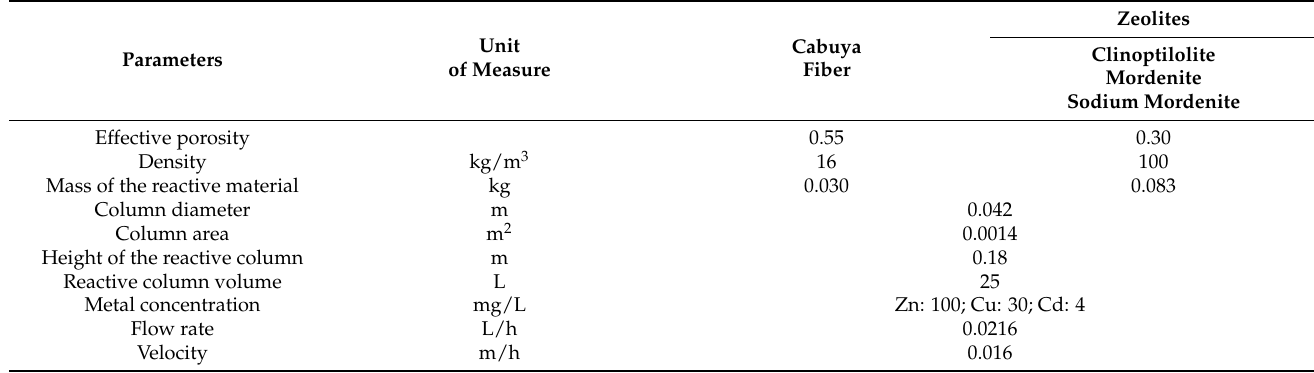
Table 1. Experimental operation details using column